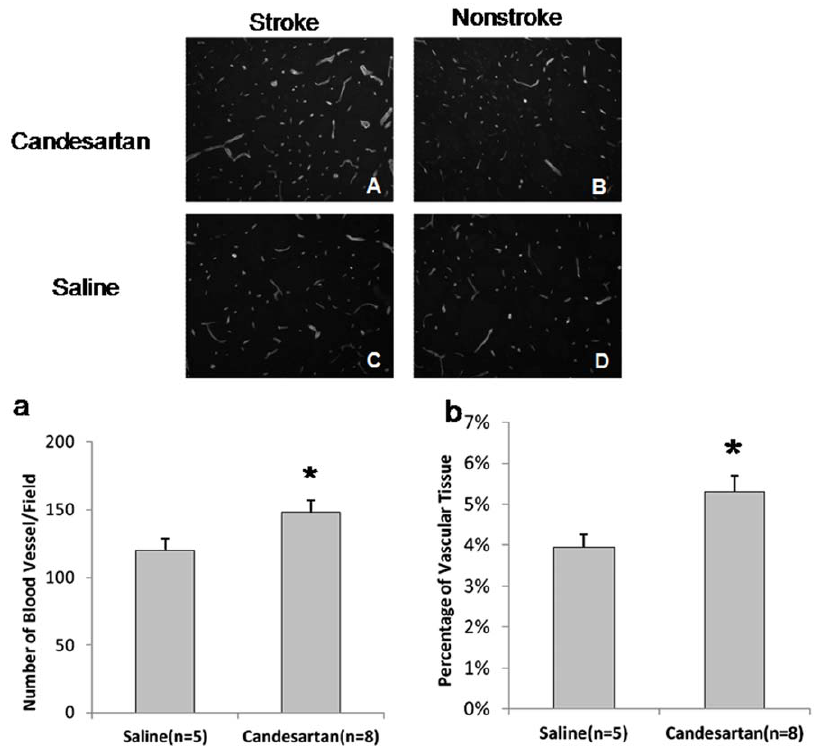
Figure 9. Vascular density. Immunohistochemical staining was performed on the brain tissue from candesartan and saline treated animals 7 days after stroke onset. Treatment with candesartan significantly increased the number of blood vessels (*P , 0.05) (Figure 9a) and the percentage of vascular tissue (*P , 0.05) (Figure 9b) compared with saline-treated animals in the nonischemic hemisphere.